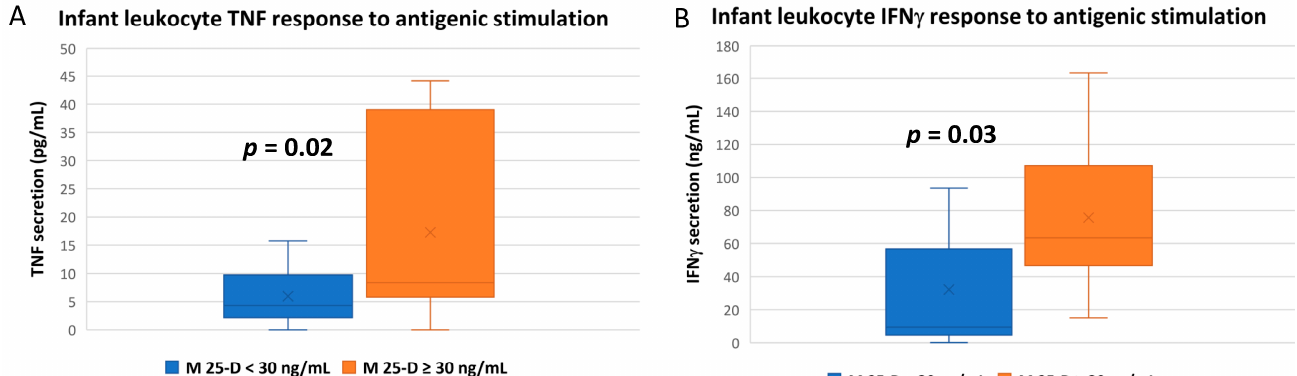
Figure 3. TNF and IFN γ responses of infant leukocytes to in vitro antigenic stimulation. Whole blood from breastfeeding infants was stimulated with antigen stock mixture for 20 h; culture super- natants were then collected for cytokine measurement by electrochemiluminescence. Mean cytokine concentrations compared between infants based on maternal vitD sufficiency (maternal plasma 25-D ≥ 30 ng/mL; unpaired t -tests) at the corresponding time of blood draw. ( A ) Mean infant TNF. ( B ) Mean infant IFN γ .